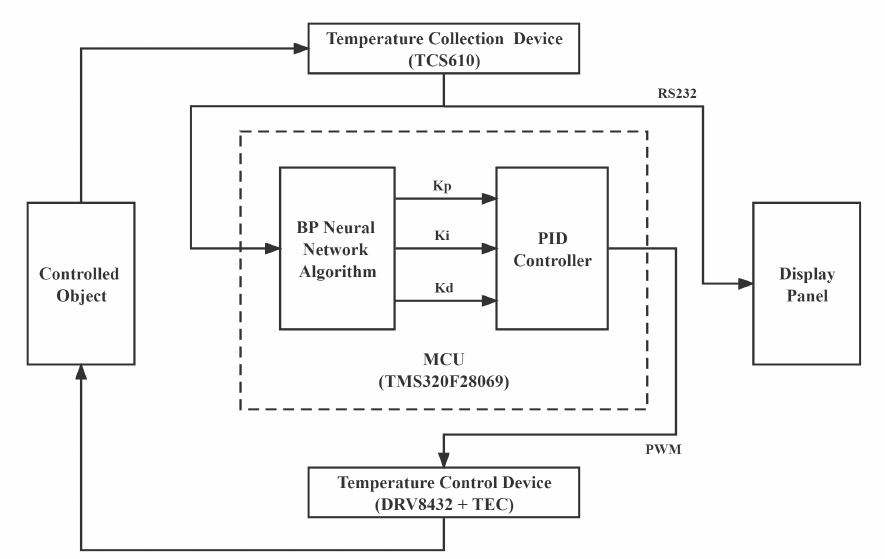
Figure 2. Framework of the Laser Temperature Control System. BP, back propagation; MCU, micro control unit; PWM, pulse width modulation; TEC, thermoelectric cooler; PID, proportion-integration-